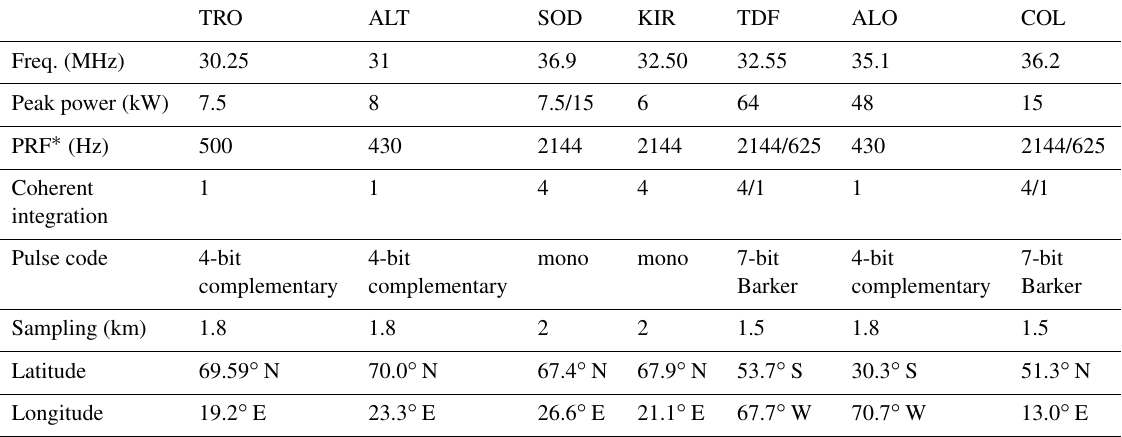
Table 1. Technical parameters of the Nordic Meteor Radar Cluster (SOD, KIR, ALT, TRO), CONDOR (ALO), Tierra Del Fuego (TDF), and Collm (COL). TRO ALT SOD KIR TDF Freq. (MHz) Peak power (kW) 500 integration Pulse code 4-bit 4-bit mono complementary complementary Barker complementary Barker Sampling